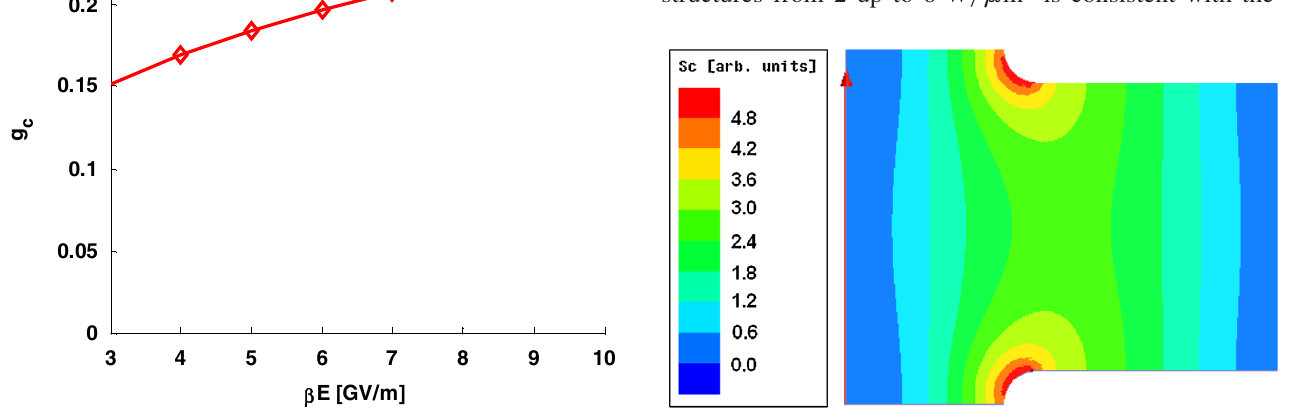
in a TWS cell. The first cell c